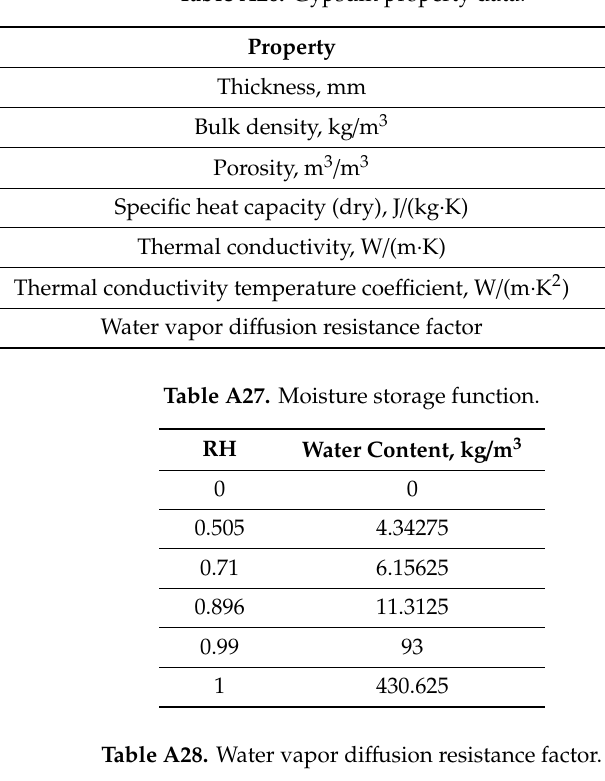
Table A26. Gypsum property data.